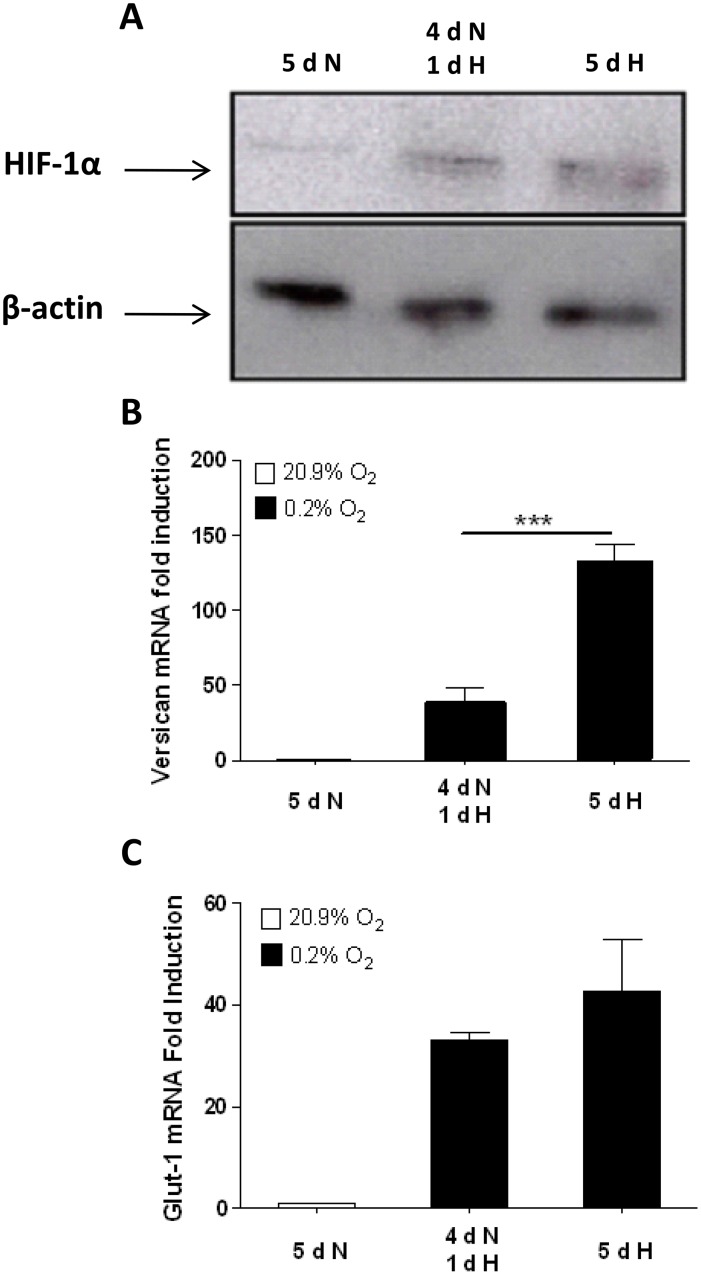
Immunoblotting shows lack of correlation between HIF-1α protein level and versican mRNA up-regulation by hypoxia.
(A) After incubation under the conditions indicated, cell lysates were prepared from HMDM and immunoblotted for HIF-1α and actin. A blot representative of 3 independent experiments is shown. (B and C) Real time-PCR analyses show versican and GLUT-1 mRNA fold induction after 5 days of normoxia, 4 days of normoxia followed by 1 day of hypoxia, or 5 days of hypoxia. N: normoxia (20.9% O2), H: hypoxia (0.2% O2). Data were normalized to 2MG mRNA levels. Data from 3 independent experiments are expressed as means ± SEM. The normoxic value in each experiment was assigned an arbitrary value of 1. Data were further analyzed using two-tailed, paired t-tests. *** p< 0.001